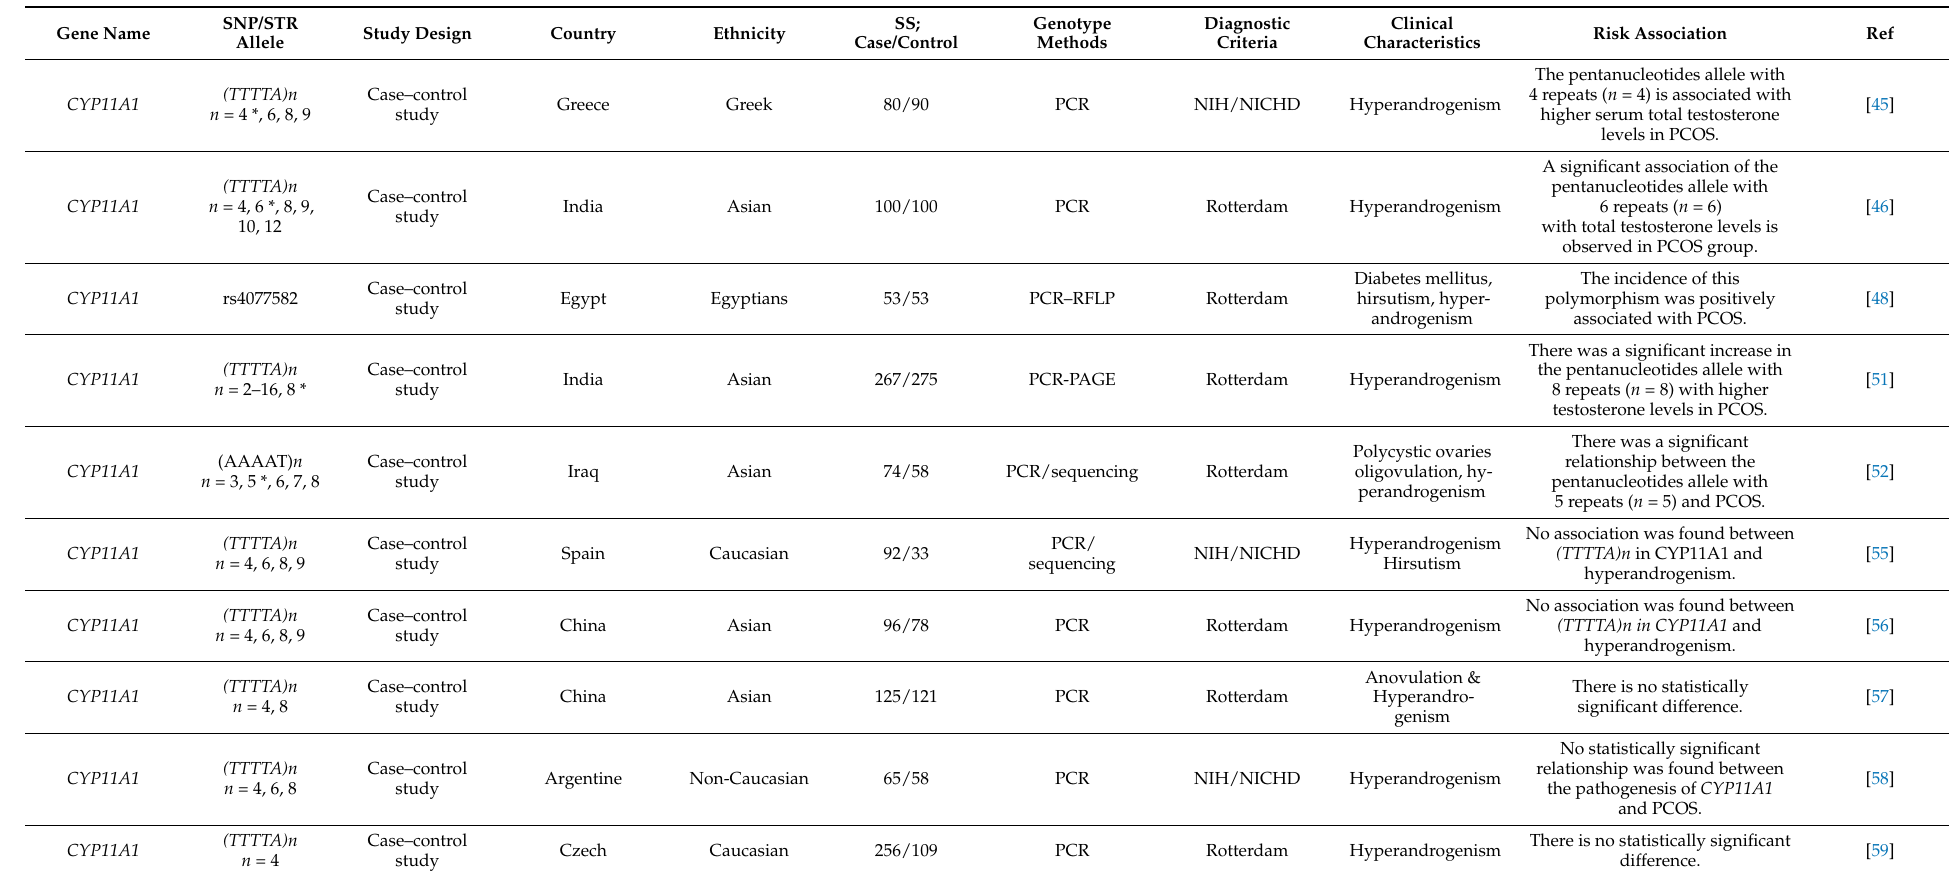
Table 1. Correlation between CYP11A1 genetic variants and PCOS with